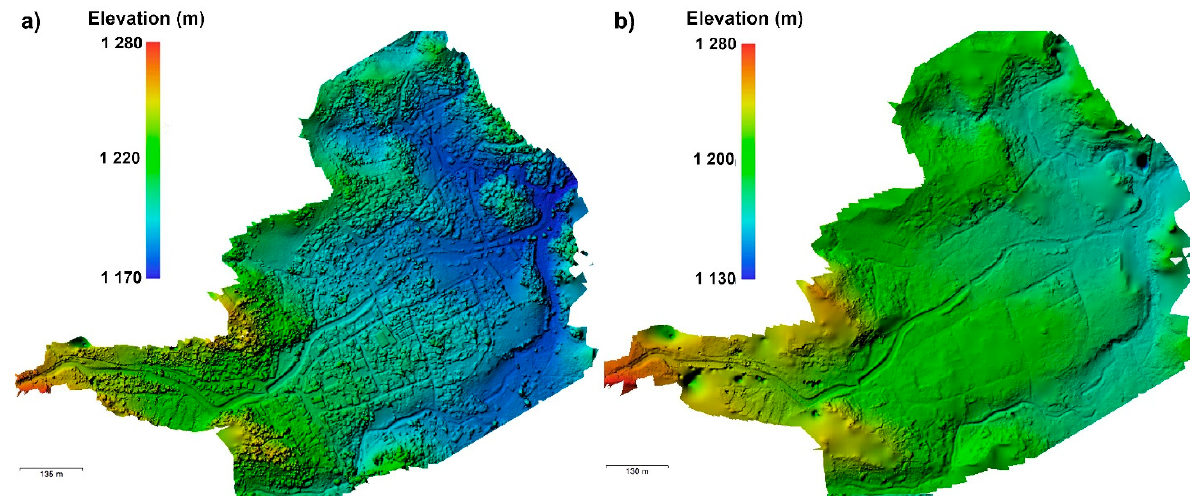
Figure 8. ( a ) Digital surface model and ( b ) digital terrain model [16].